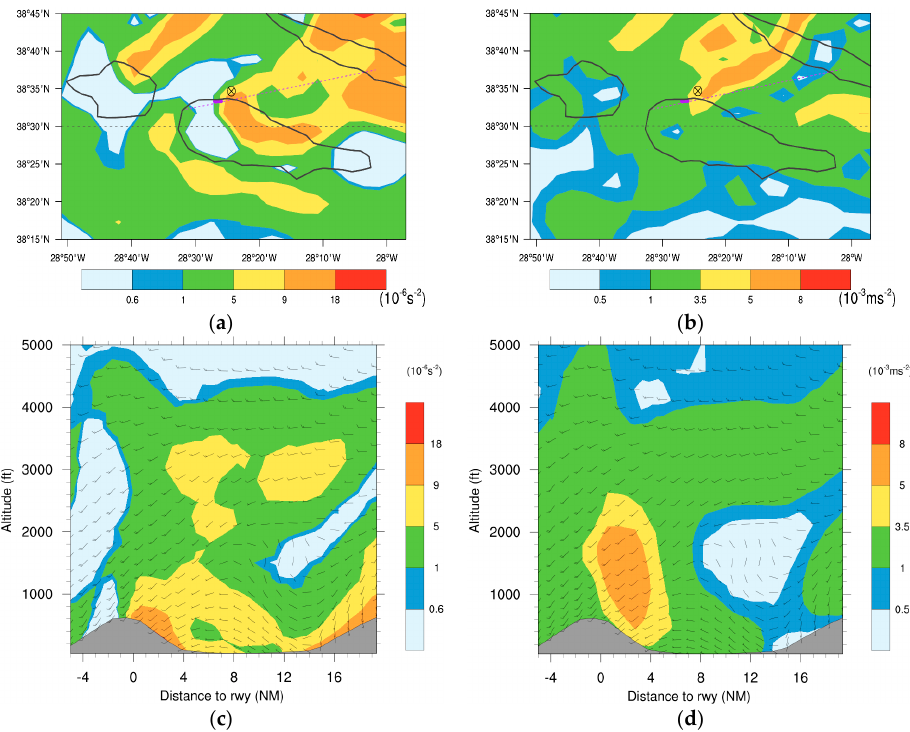
Figure 17. Horizontal variation of ( a ) Ellrod TI2 and ( b ) CAT1 at 66 m for Flight 2. Dotted pink line shows the aircraft trajectory and pink bar indicates the aerodrome. The circled “X” mark identifies the approximate aircraft position at 66 m. Cross-sectional variation of ( c ) Ellrod TI2 and ( d )